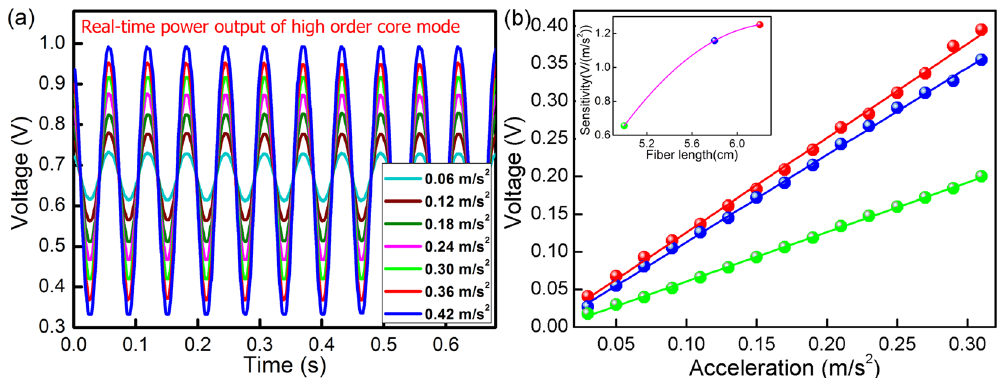
Figure 5. ( a ) Real-time power output of the fundamental core mode versus the applied acceleration, ( b ) linear response output of sensors with different free fiber lengths versus the applied accelerations, whereby inset shows the sensitivity versus the sensor